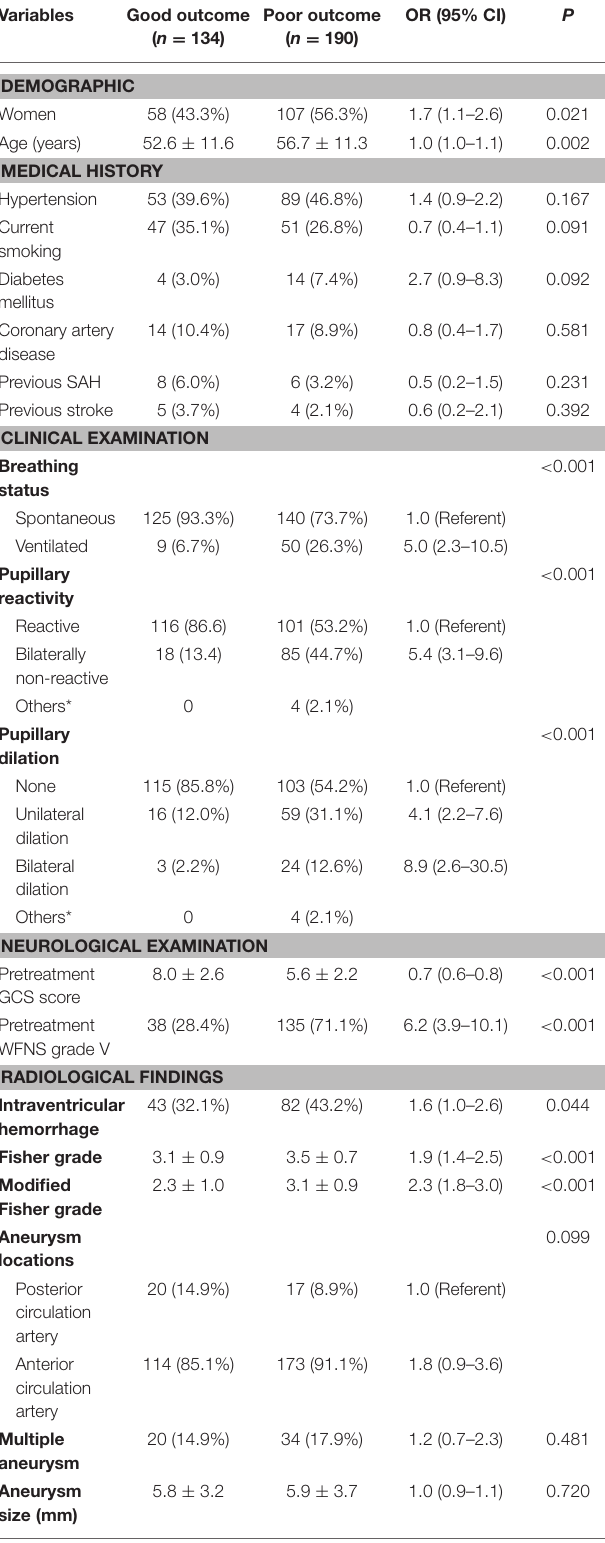
TABLE 1 | Baseline characteristics of eligible 324 cases of patients with poor aSAH.